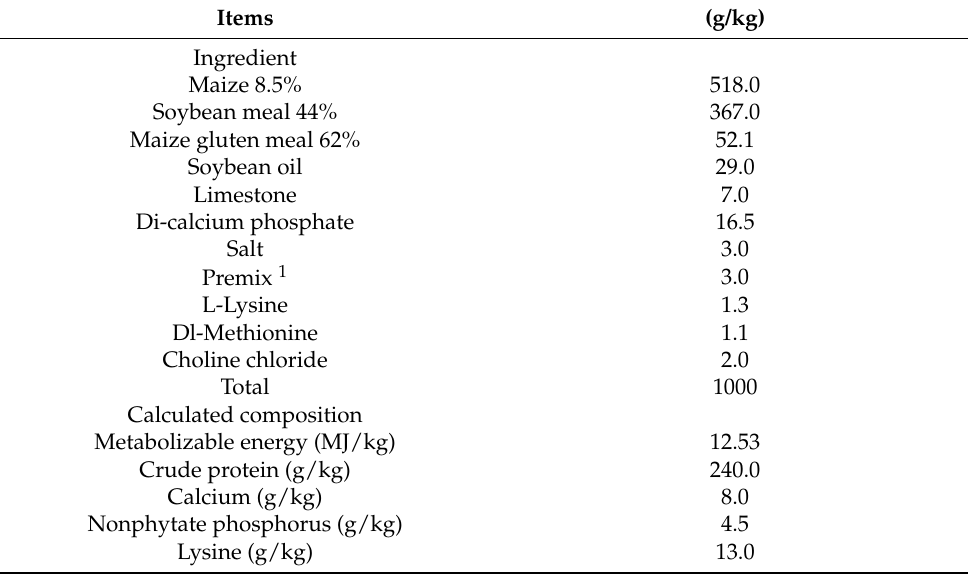
Table 1. Ingredients and nutrient contents of basal diet for growing Japanese